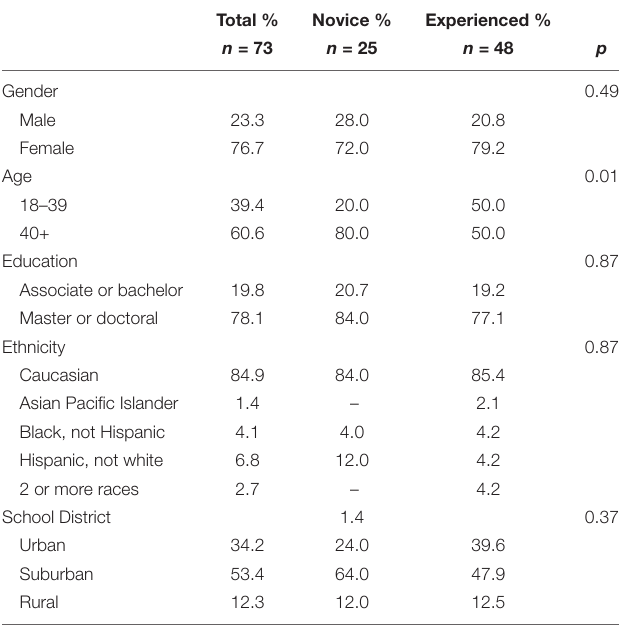
TABLE 1 | Sample demographics by social media experience (Chi-square